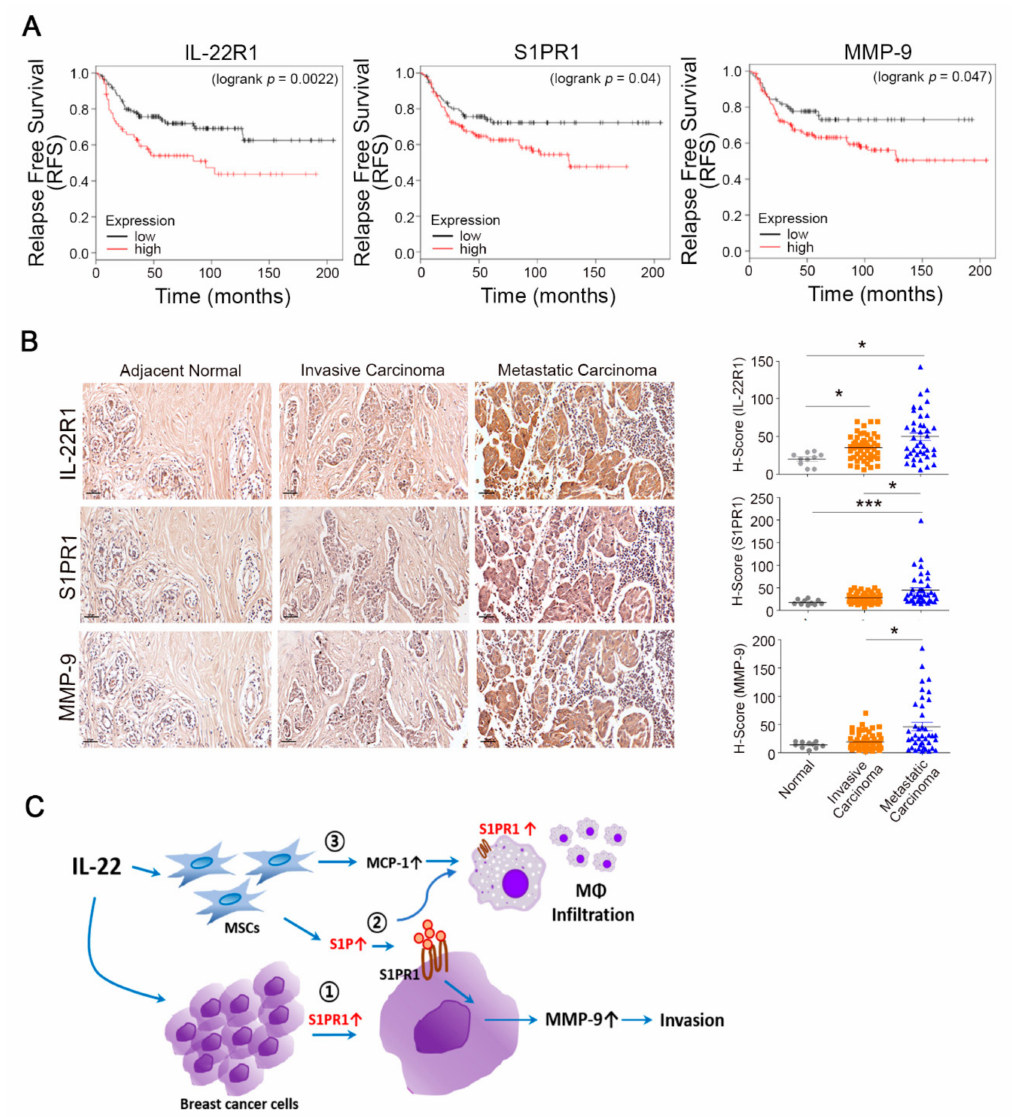
Figure 5. Prognostic value of the IL-22R1, S1PR1, and MMP-9 expression levels in breast tumors. ( A ) Relapse free survival curve of tumor IL-22R1, S1PR1, and MMP-9 expression in breast cancer patients ( n = 425). The breast tumor IL-22R1, S1PR1, and MMP-9 levels were negatively associated with the overall survival or relapse free survival of breast cancer patients, as demonstrated by the Kaplan–Meier survival curves. The significance of these associations was determined using the log rank test. ( B ) The expression of IL-22R1, S1PR1, and MMP-9 protein was determined by immunohistochemical analysis (IHC) in normal, invasive breast carcinoma, and metastatic breast carcinoma specimens. Representative IHC photomicrographs are shown. Scale bar, 500 µ m. H-scores determined by multiplying the staining intensity by the percentage of positive tumor cells. The expression patterns in the tested samples (100 breast tumor specimens) are shown. * p < 0.05, *** p < 0.001 vs. indicated group. ( C ) Schematic diagram of the proposed mechanism by which IL-22 regulates breast cancer